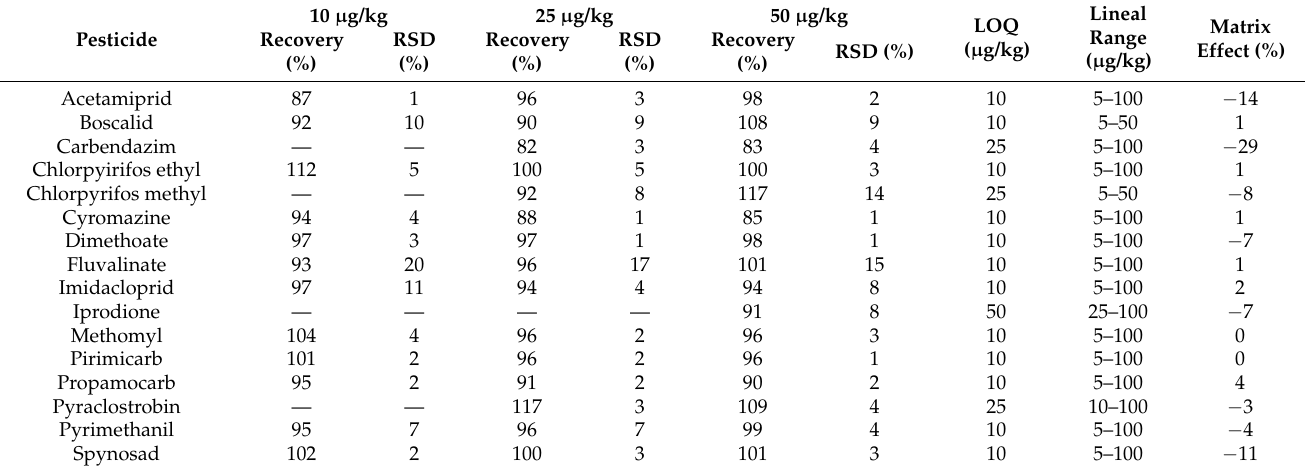
Table 1. Recoveries, relative standard deviations (RSD), limits of quantitation (LOQ), linear ranges and matrix effects obtained for each pesticide.